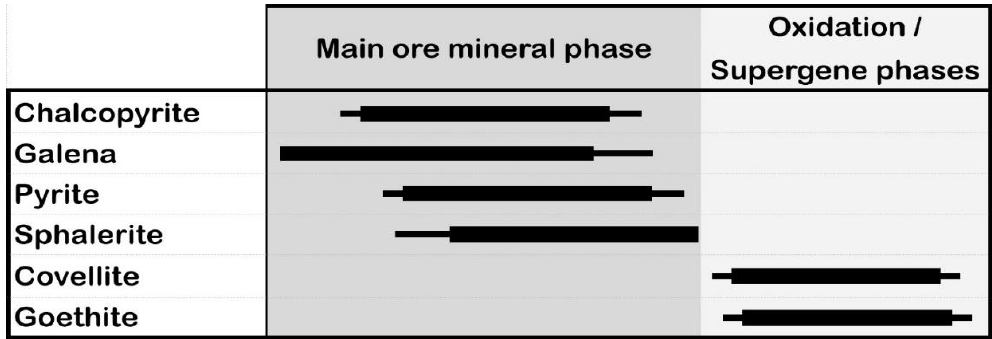
Figure 9. Paragenetic sequence of mineralization phases in the Halılar area.